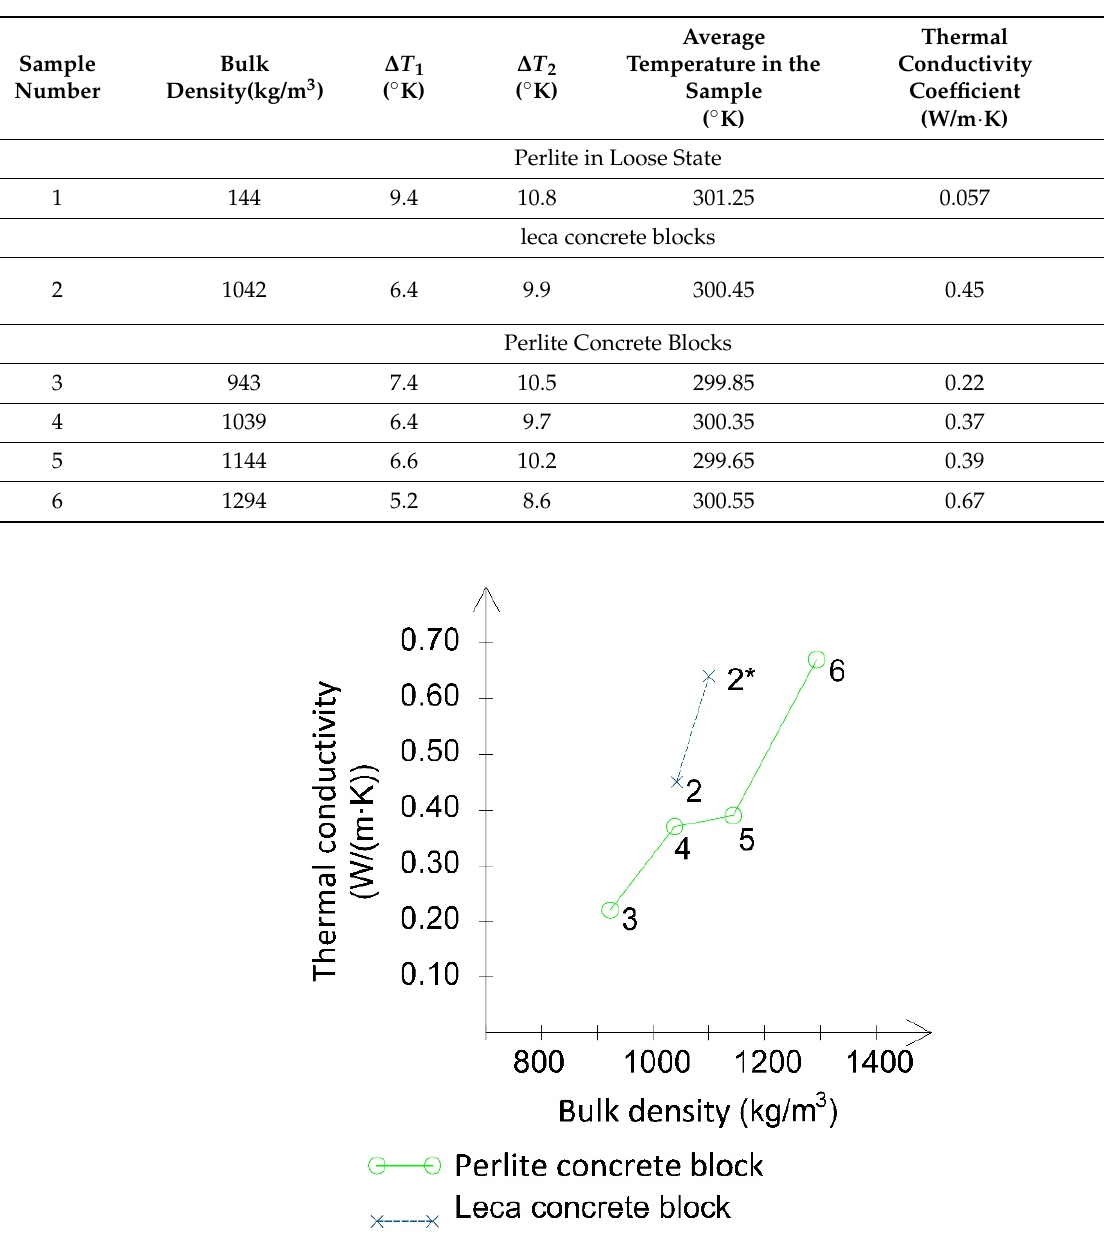
Table 2. Main characteristics of the analysed perlite and leca concrete samples.